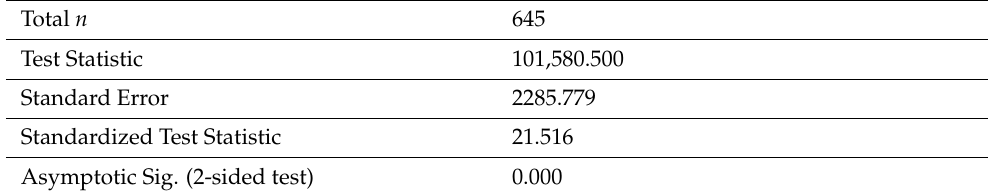
Table 5. PMVA independent-samples Jonckheere–Terpstra test for ordered alternatives summary.